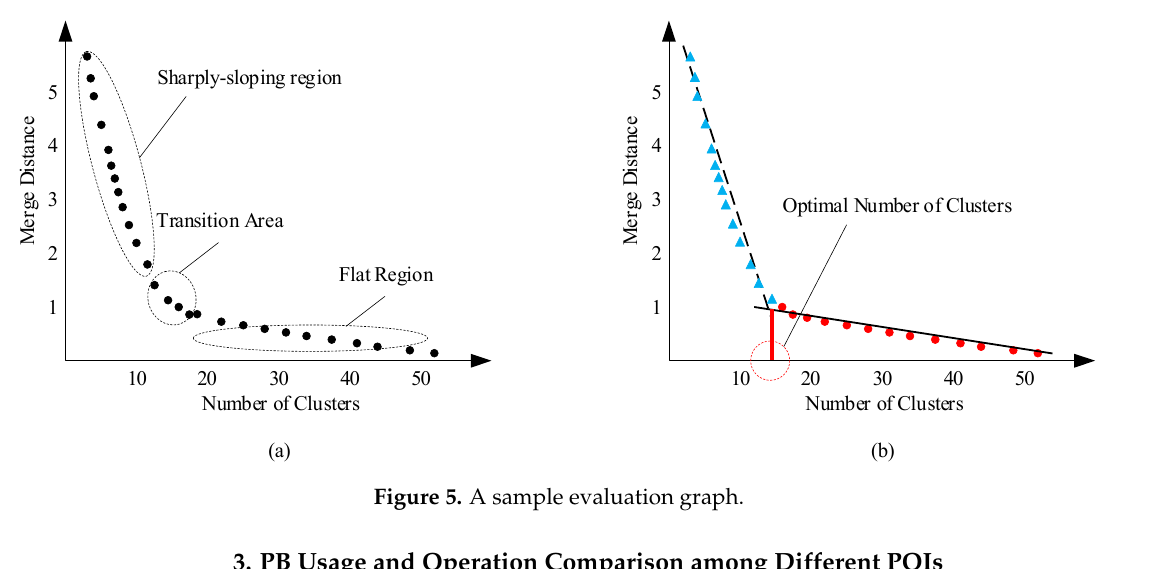
Figure 5. A sample evaluation graph.